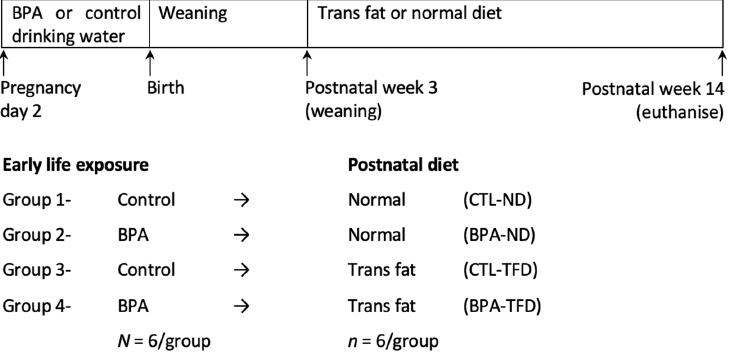
Figure 1. Experimental timeline. Pregnant rats were given either BPA or control (CTL) drinking water throughout pregnancy. Fully weaned offspring were allocated into one out of four study groups (control offspring on normal diet (CTL-ND); BPA-exposed offspring on normal diet (BPA- ND); control offspring on trans fat diet (CTL-TFD); BPA offspring on trans fat diet (BPA-TFD)). Adult offspring were euthanised on postnatal week (PNW) 14 for organ collection. were euthanised on postnatal week (PNW) 14 for organ